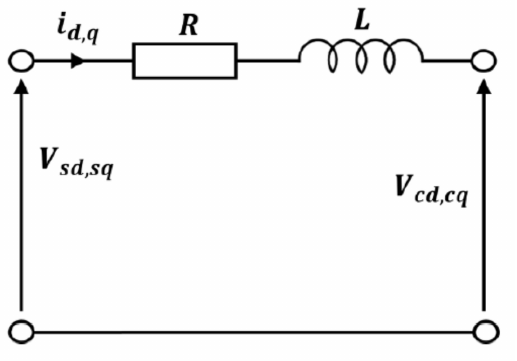
Figure 4. Thevinin’s equivalent circuit for inner d-q current